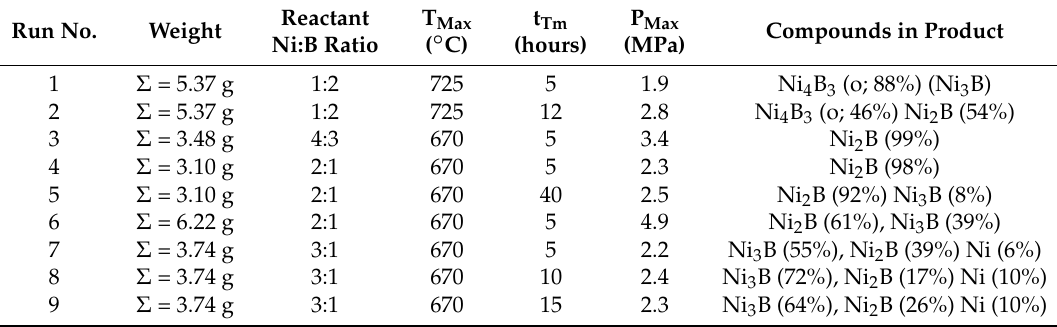
Table 1. Synthesis conditions for Ni-B